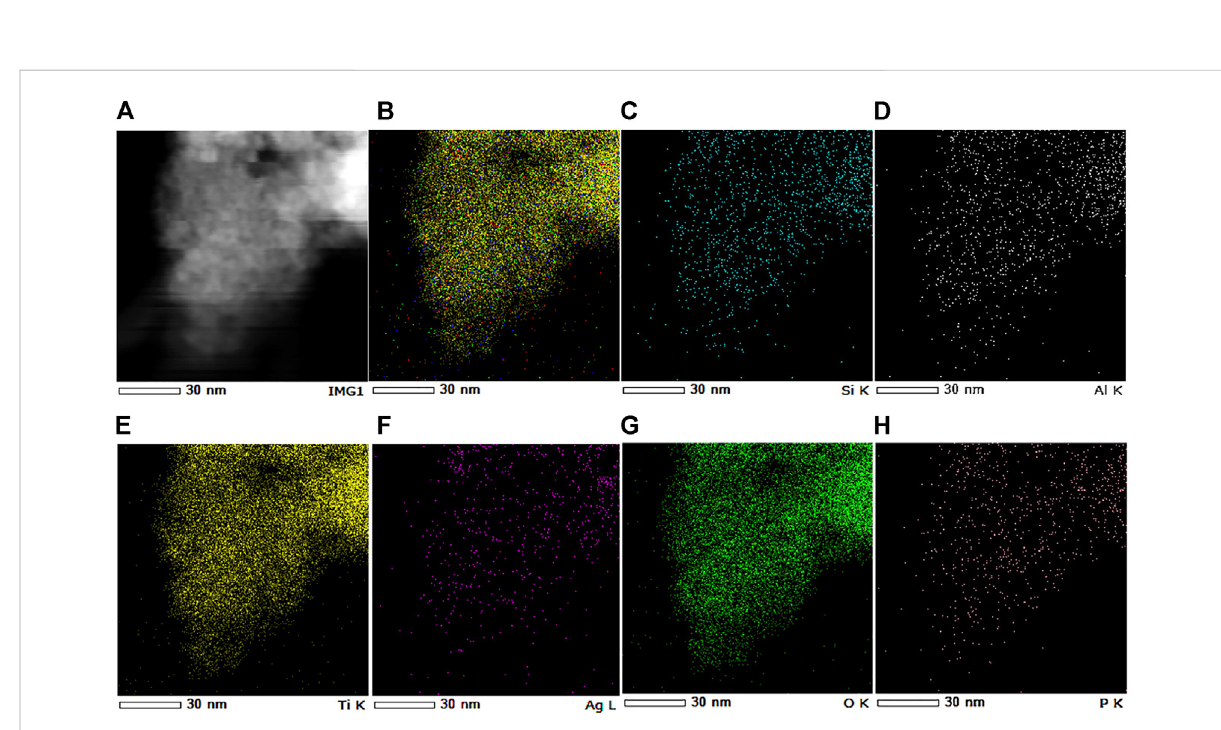
FIGURE 4 Selectedarea (A) andthecorrespondingEDSelementalmappingofZ-PAgT-5composite: (B) themergedimageofallelements, (C) Si, (D) Al, (E) Ti, (F) Ag, (G) O, and (H) P